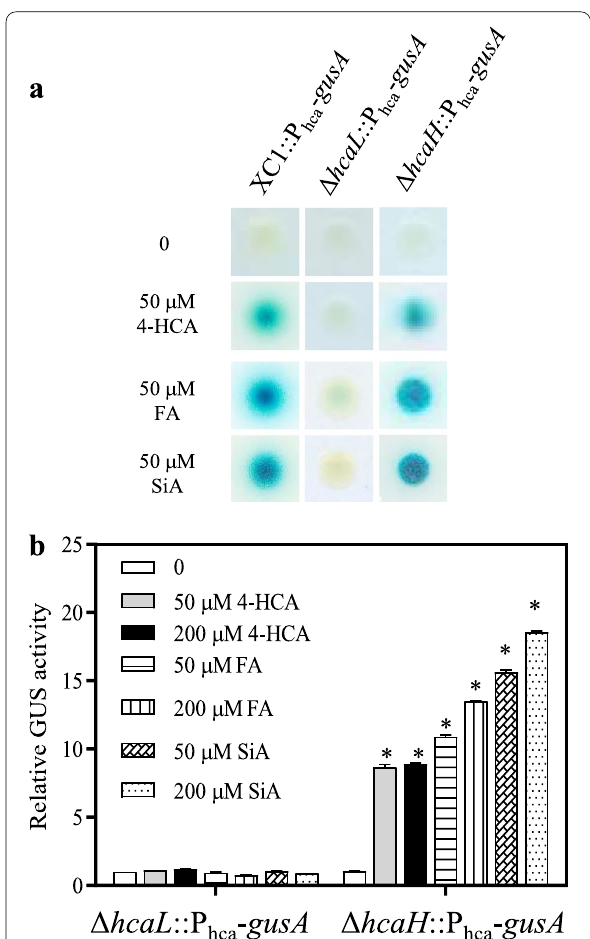
Fig. 5 The effect of hydroxycinnamoyl‑CoA accumulation on hca transcription in Xcc . a P hca ‑dependent GUS activity of three reporter strains on NYG agar medium supplemented with 50 μM HCAs.